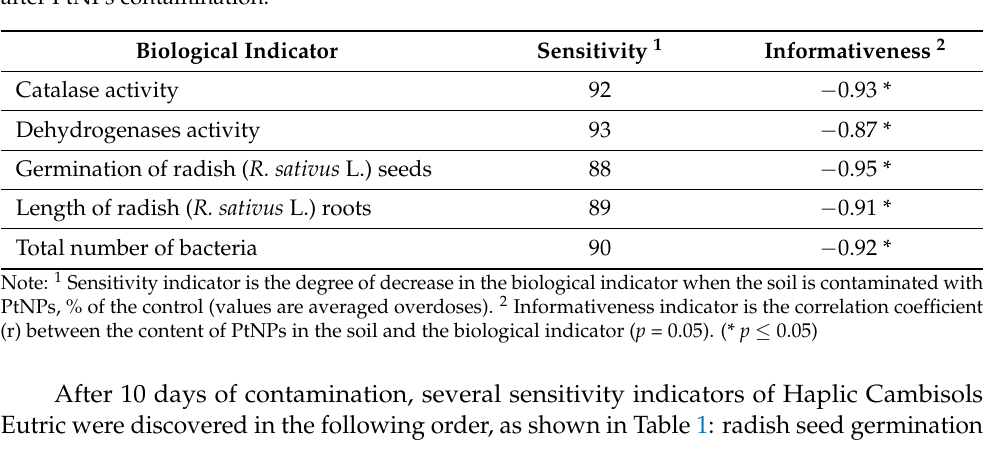
Table 1. The sensitivity and information value of biological indicators of Haplic Cambisols Eutric after PtNPs